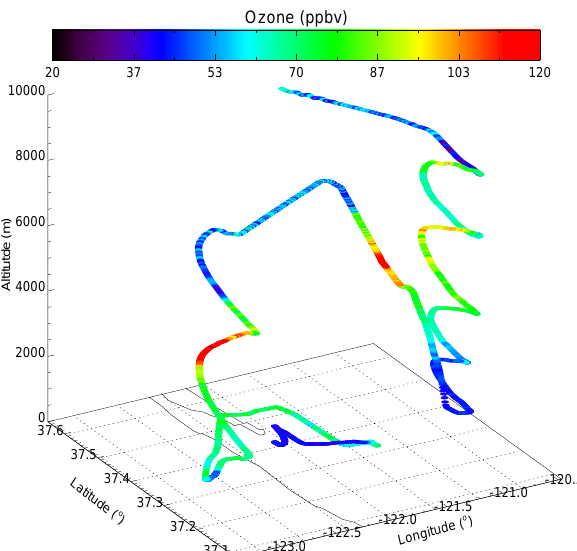
Fig. 1. 3-D projection of O 3 mixing ratio (ppbv) as observed during flight on 14 May 2012 (takeoff time: 18:00UTC). The O 3 monitor requires a 10min warm-up period before stable measurements are made, which results in data acquisition starting at 8.4km during the transit to the San Joaquin Valley (inland)